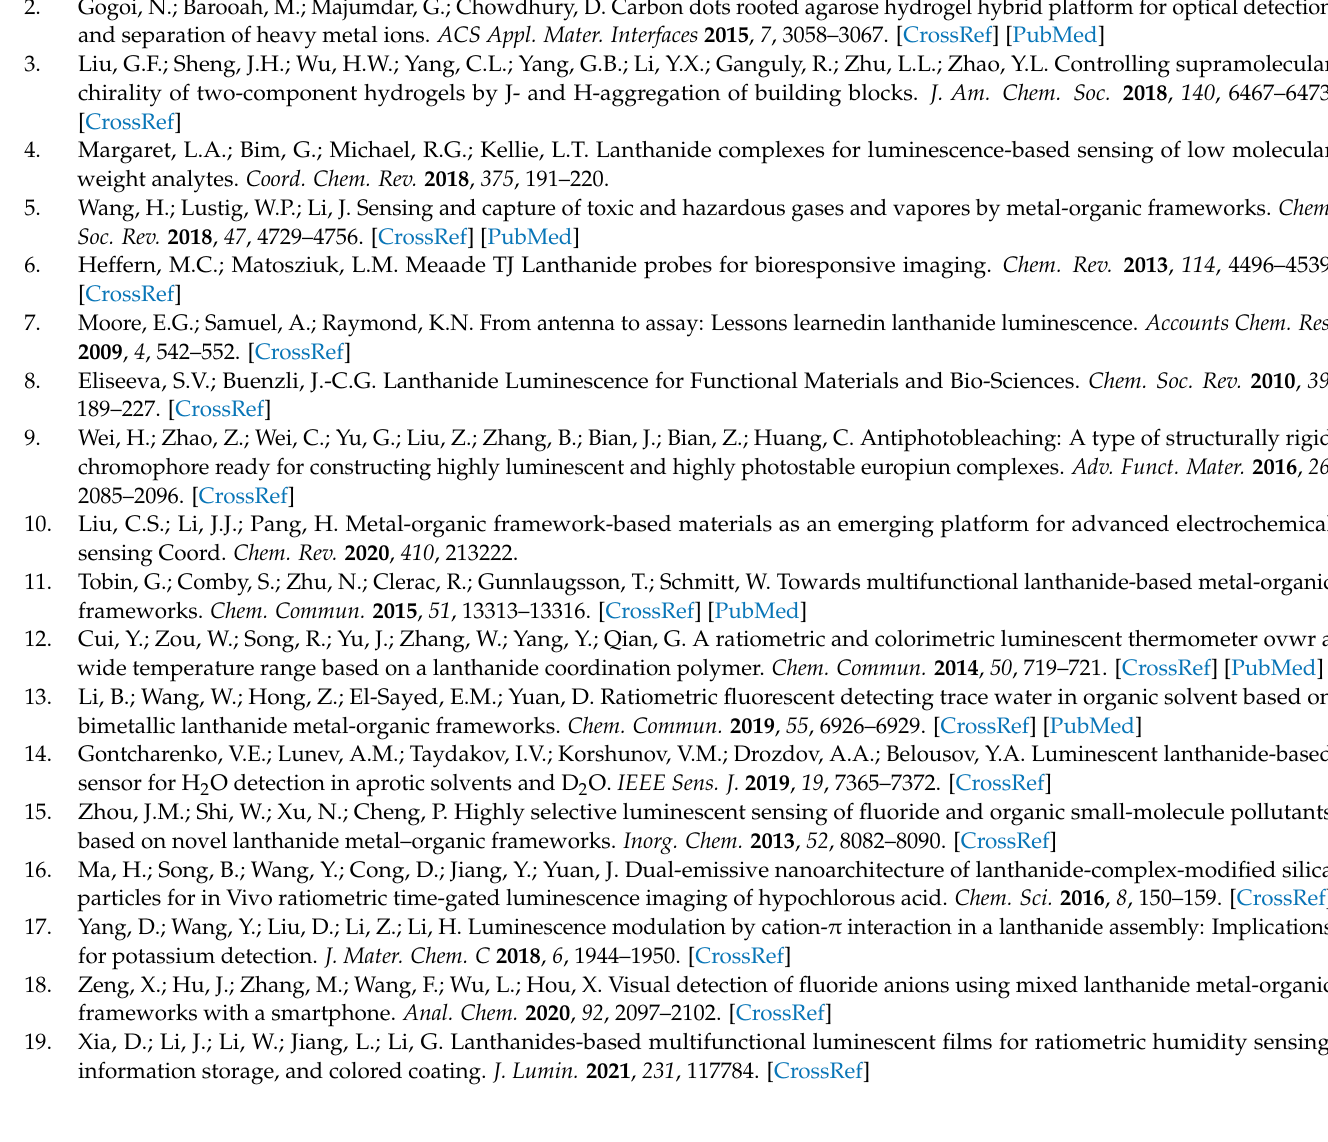
(b), respectively. Figure S5. The CIE chromaticity diagram of Eu/Tb-PMA-MPEG solutions after treatment with various amounts of Fe 3+ ions under the excitation wavelength of 360